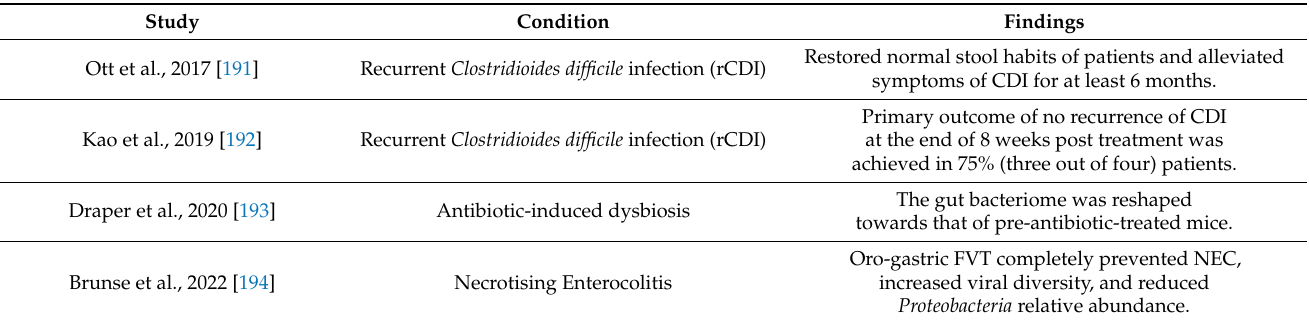
Table 10. Studies in non-IBD patients showing the benefit of